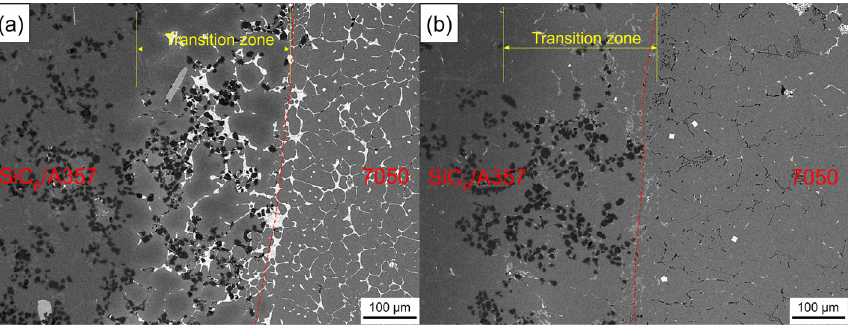
Figure 16. SEM backscattered photograph of the solid–liquid bonding interface in as-cast ( a ) and T6 ( b ) status.